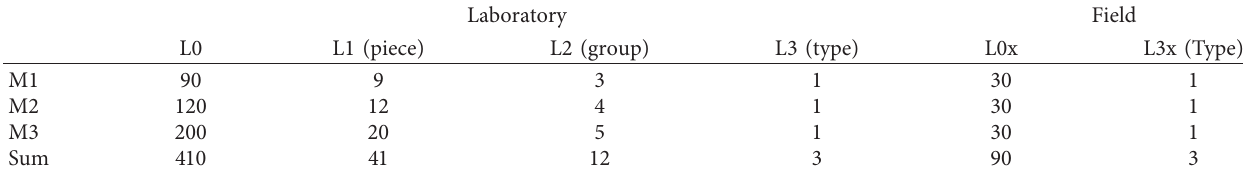
Table 2: The number of measurements conducted in the laboratory and in the